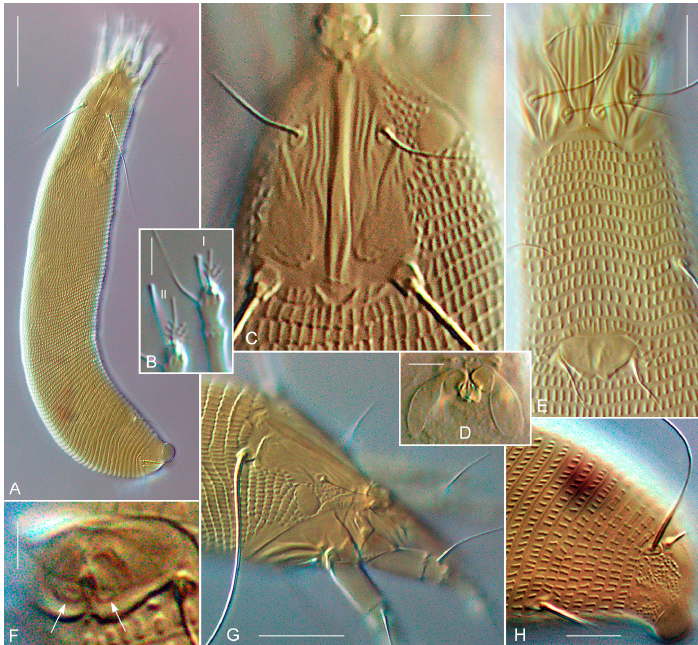
Figure 6. DIC LM images of Novophytoptus zuluensis n. sp. (females). ( A )—dorsal view of entire mite, ( B )—tarsal appendages I and II, ( C )—prodorsal shield, ( D )—internal genitalia, ( E )—coxigenital area, ( F )—two pores (arrows) leading to spermathecal tubes, ( G )—lateral view of prosoma, ( H )—telosome. Scale bar: ( A ) = 40 µ m, ( B ) = 4 µ m, ( C , E , H ) = 10 µ m, ( D ) = 5 µ m, ( F ) = 2 µ m, ( G ) = 15 µ m.